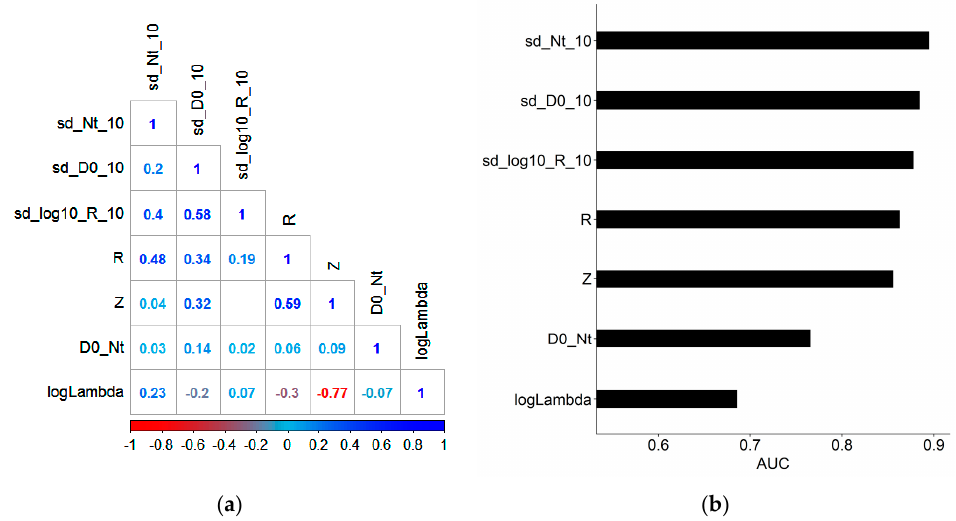
Figure 6. ( a ) Correlation matrix where blank cells represent insignificant correlation with confidence level of 0.95. ( b ) AUC values of the final list of selected